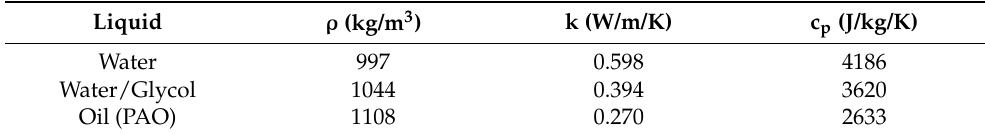
Table 3. Comparison of typical liquids used in liquid cooling